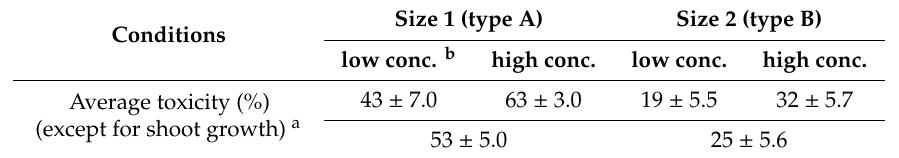
Table 2. Summary of the average toxicities of eight biological activities in the presence of